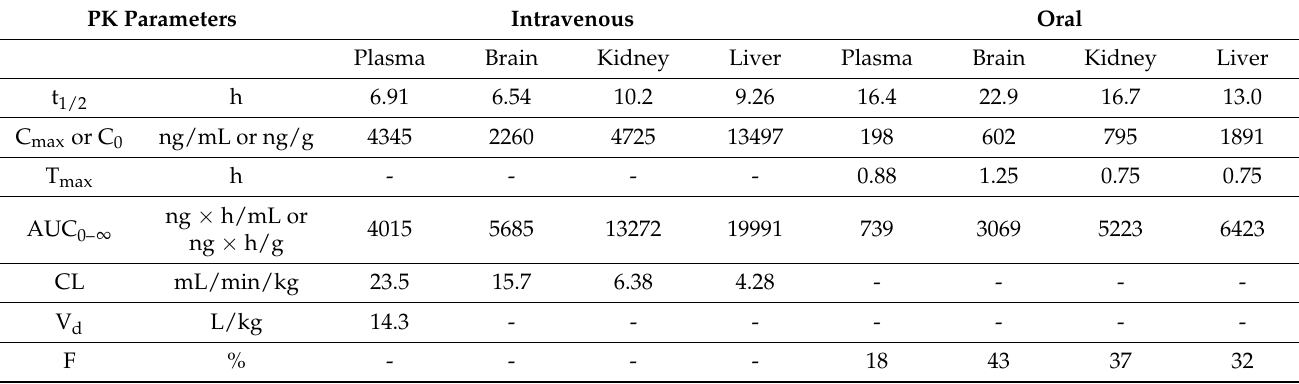
Table 3. Pharmacokinetic parameters of compound 4k in CD1 mice following intravenous and oral dosing of 4k in mice at 5